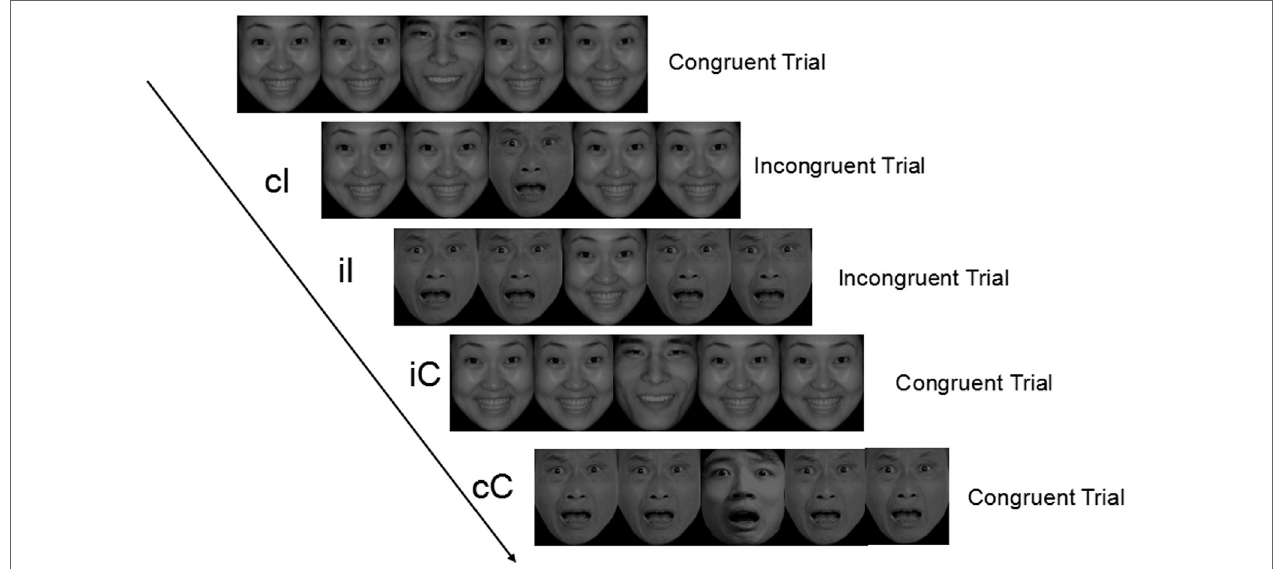
FigUre 1 | Graphical representation of trials and experimental conditions. cC, congruent trials preceded by congruent trials; cI, incongruent trials preceded by congruent trials; iI, incongruent trials preceded by incongruent trials; iC, congruent trials preceded by incongruent